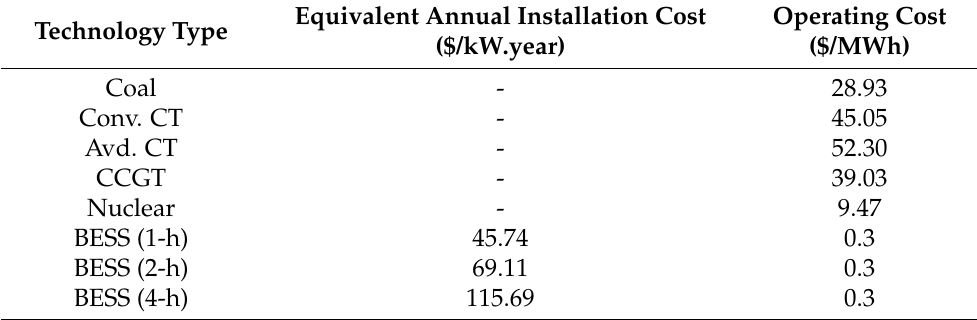
Table 1. Installation and operating costs of generators and battery energy storage systems (BESSs).